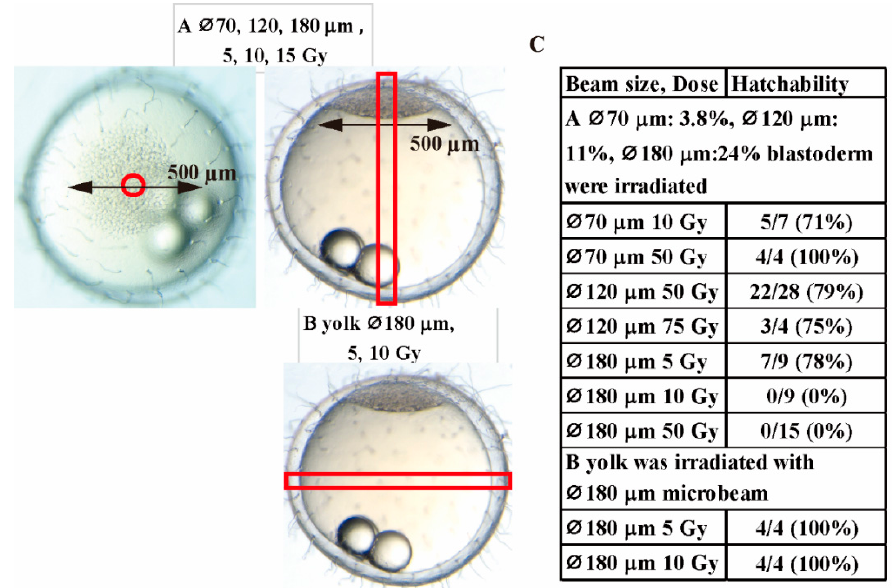
Figure 3. Targeted irradiation with a collimated carbon-ions microbeam on blastula embryo of medaka. The center part of blastoderm (diameter: 500 µ m) was irradiated with a collimated carbon-ions microbeam with various diameters (70, 120, and 180 µ m) and doses (5, 10, 50 and 75 Gy) ( A ). Yolk was irradiated with 5 and 10 Gy microbeam with 180 µ m diameter ( B ). The targeting irradiated areas are surrounded by red line in the pictures. The hatchability of blastula embryos irradiated with microbeam are summarized in ( C ).